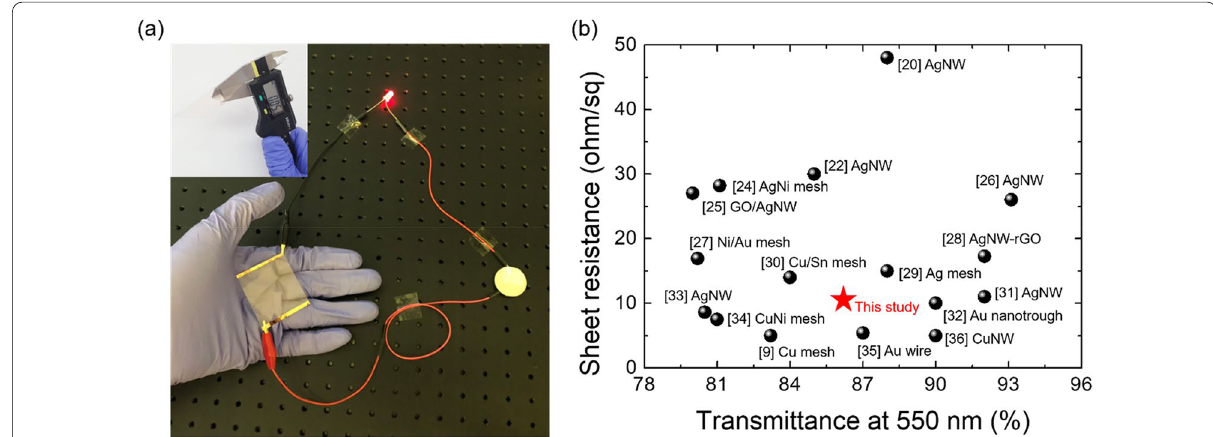
Fig. 2 a Digital photograph of the Cu mesh/PVA film (45 mm 45 mm) with ~ 50 µm thick PVA substrate as a transparent conductor in an × electronic circuit connected to a LED. b Comparison of the optical transmittance and sheet resistance of the Cu mesh/PVA film with ~ 50 µm thick PVA substrate fabricated this study, and those of previously reported metal‑based transparent conductors. The numbers in the square brackets indicate the cited references